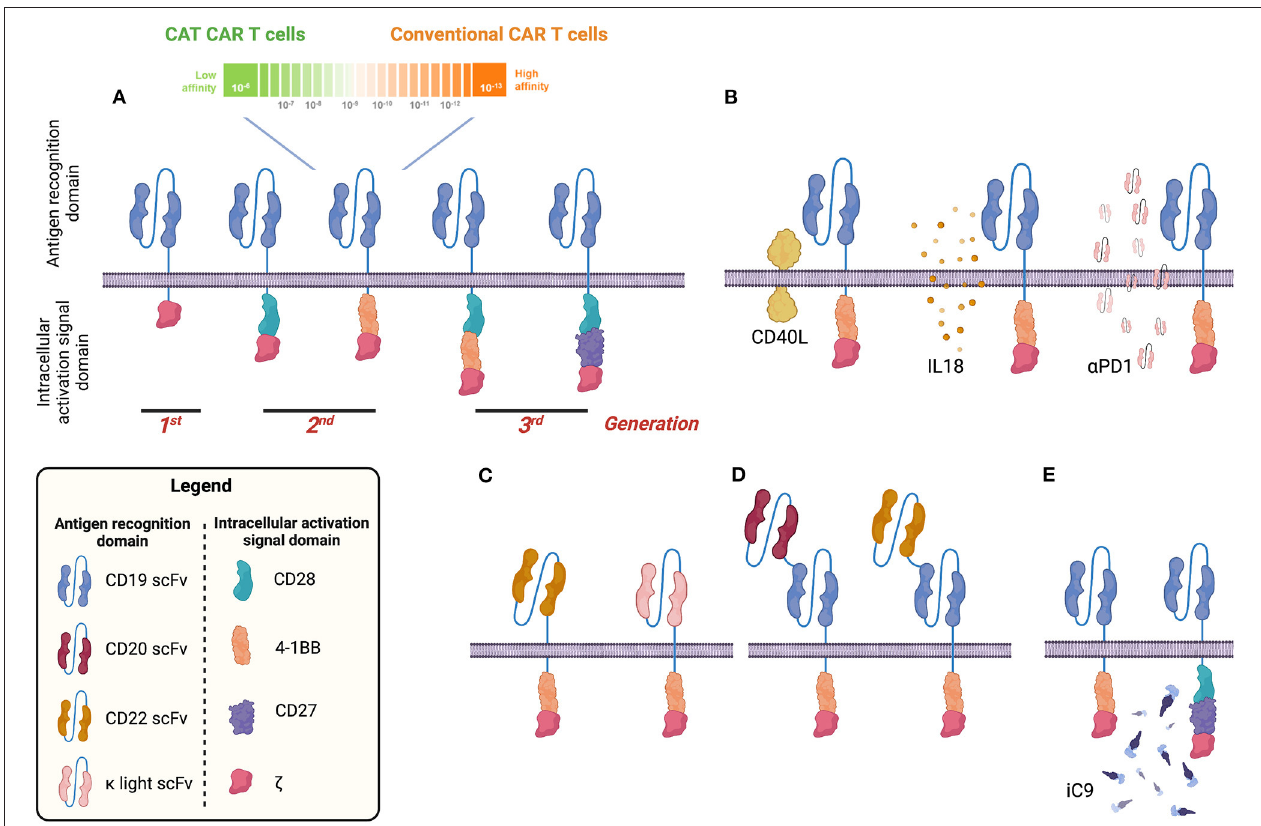
FIGURE 1 | Visual summary of different chimeric antigen receptor (CAR) designs to target B-cell malignancies. CD19 CAR has been tested in many clinical trials so far. Different generations of CD19 CAR have been developed including a second-generation CD19 CAR with low affinity for the CD19 antigen (CAT CAR) (A) . Several groups proposed strategies to improve the long-term efficacy of the CD19 CAR by armoured CAR constructs capable of expressing both CD19 CAR and other molecules such as CD40L, interleukin 18 (IL-18), or programmed death 1 (PD1) capable of improving cytotoxic activity, reducing the exhaustion profile and sustaining the proliferation and persistence of CAR T cells (B) . In addition to CD19, other B-cell antigens have been investigated and CARs have been generated and tested in preclinical and early-stage human clinical studies (e.g., CD22 and κ light chain) (C) . To avoid tumour escape, bispecific CARs have been developed targeting, for example, CD19 and CD20 or CD22 (D) . To improve the safety profile and generate a tool to mitigate/abrogate side effects, a suicide gene based on an inducible caspase 9 (iC9) has been developed and validated (E) . Image created with